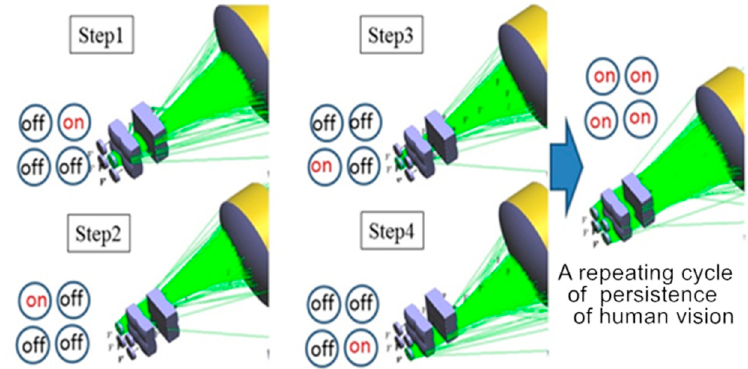
Figure 3. Steps in cycle light source micro-scanning compensation, using the repeating cycle of persistence of human vision.